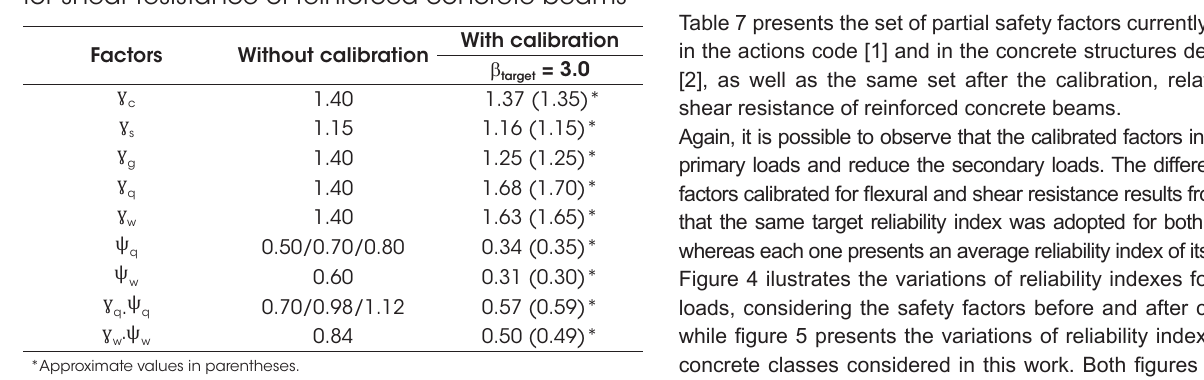
Partial safety factors with and without calibration for shear resistance of reinforced concrete beams